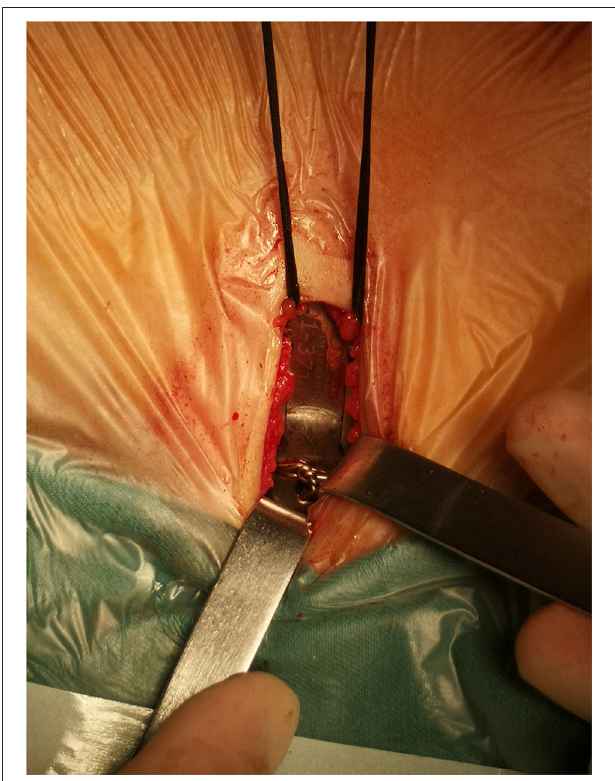
FIGURE 1 | The stabilizer was fixed with a steel wire encircled as “8”-shaped on the groove of the bar.